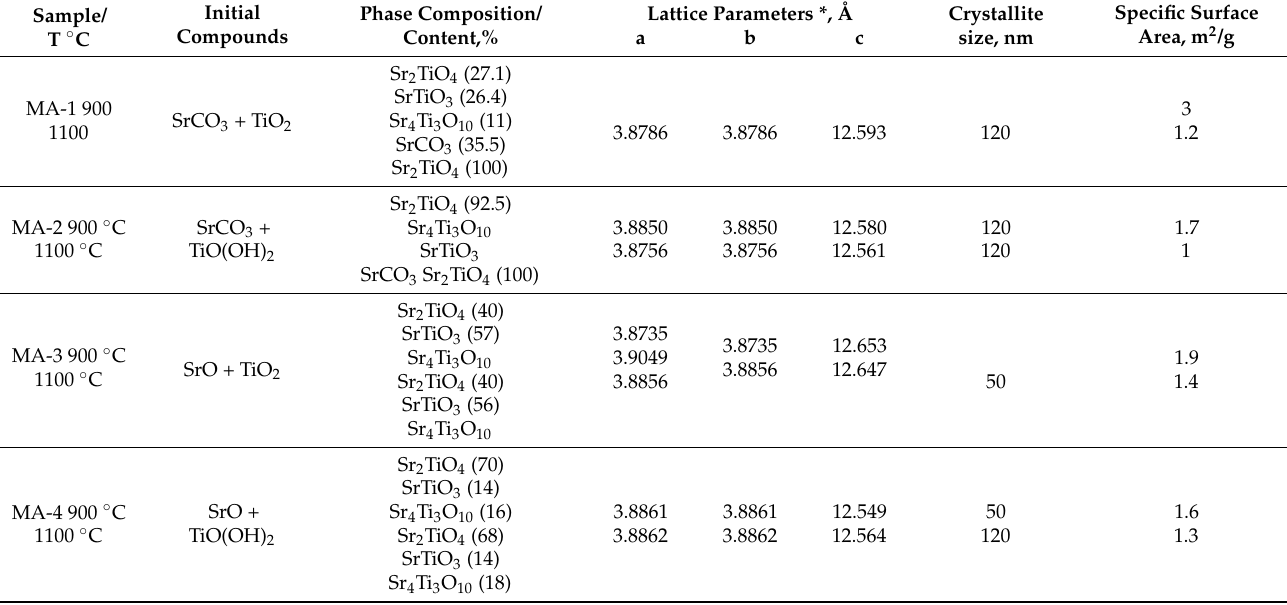
Table 1. Some characteristics of the samples after annealing of MA products at 900–1200 ◦